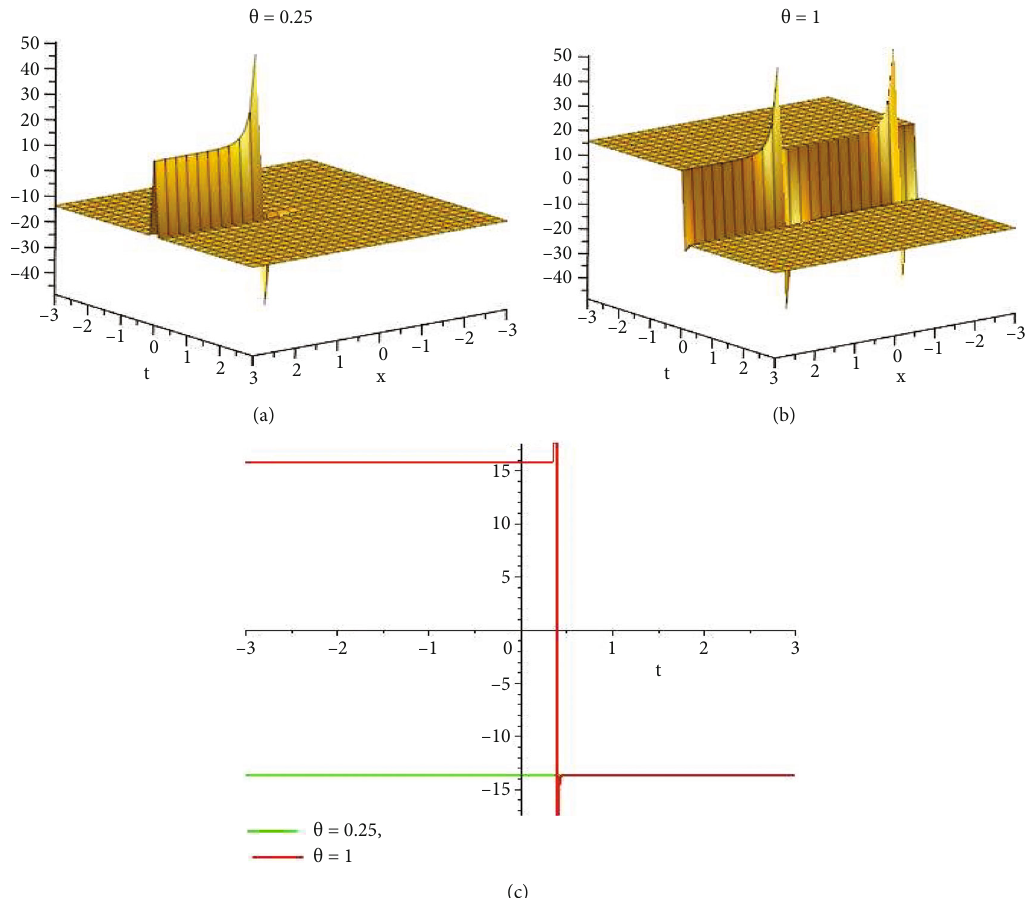
, y , t Þ . (a, b) 3D plot and (c) 2D combined plot for x = 1 1 ð x